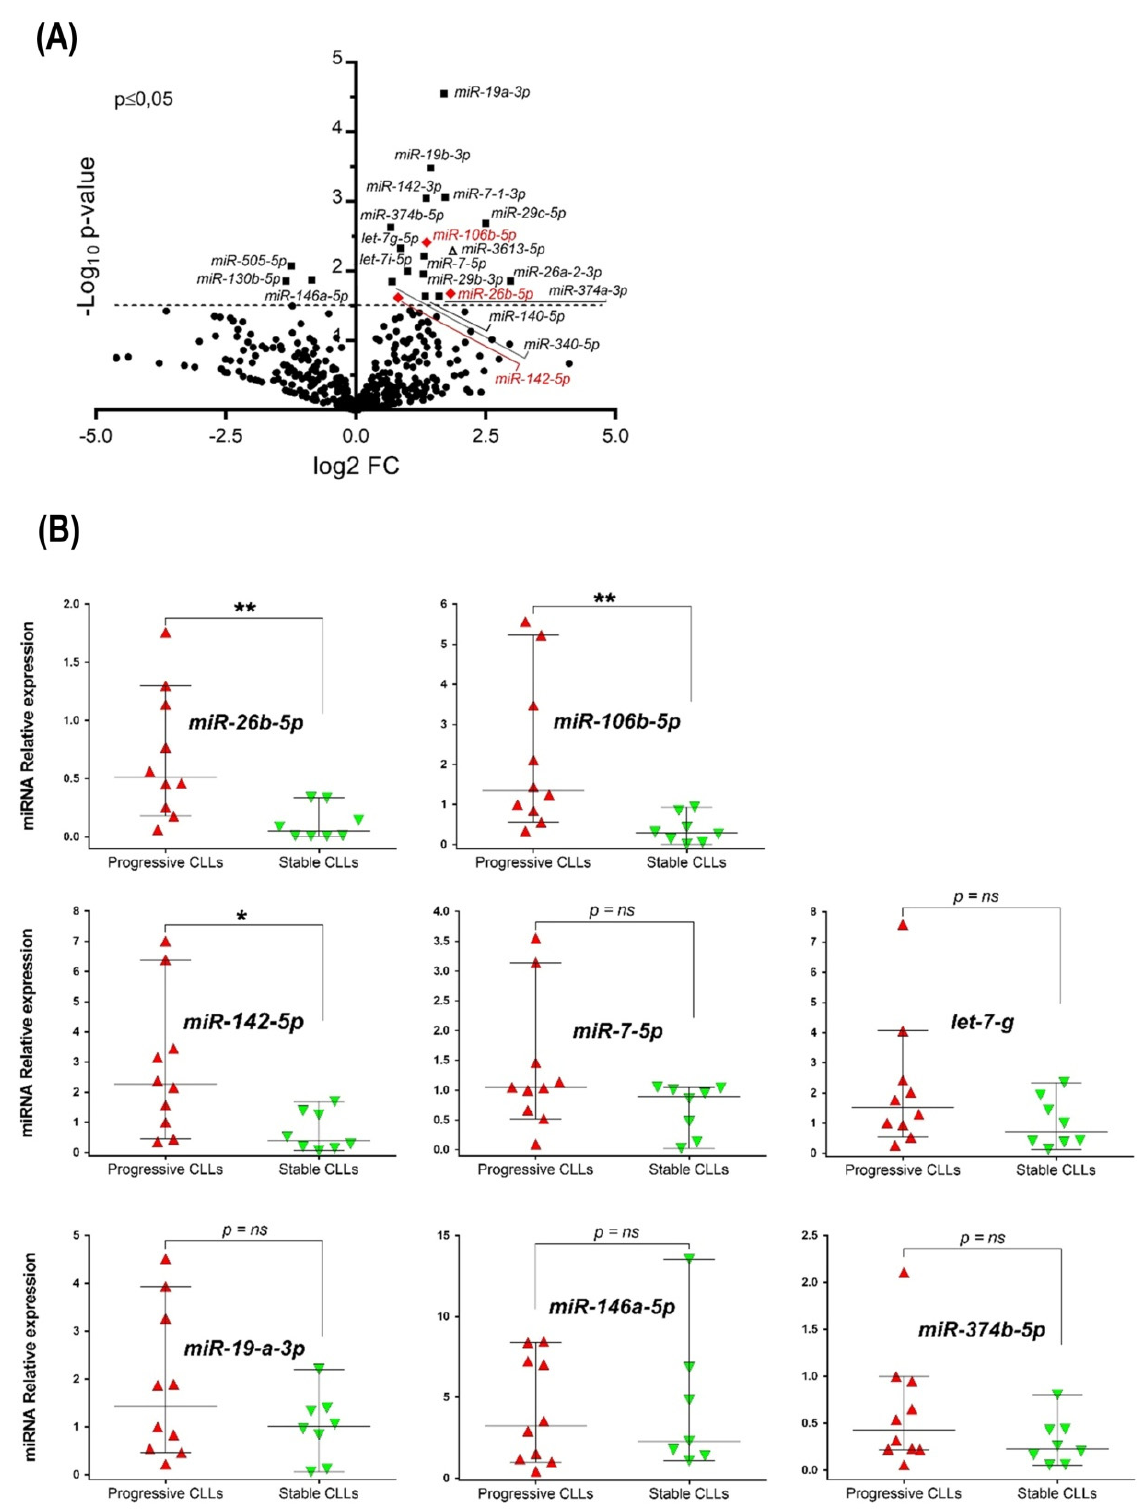
Figure 1. miRNAome analysis and data validation of selected miRNAs differentially expressed between progressive and stable U-CLL subgroups. ( A ) Volcano plot showing transcriptome analysis of eleven U-CLL patients: 5 stable patients and 6 progressive CLLs. Solid squares = miRNAs differ- entially expressed ( p ≤ 0.05). Red diamond indicates those miRNAs validated by q-PCR ( B ) Quanti- tative PCR analysis validating the initial transcriptome data. An additional larger cohort with sim- ilar biologic and clinical characteristics ( n = 15) was investigated. Mann–Whitney Unpaired test and median with 95% CI are depicted. U6 snRNA were used as endogenous quantity controls for